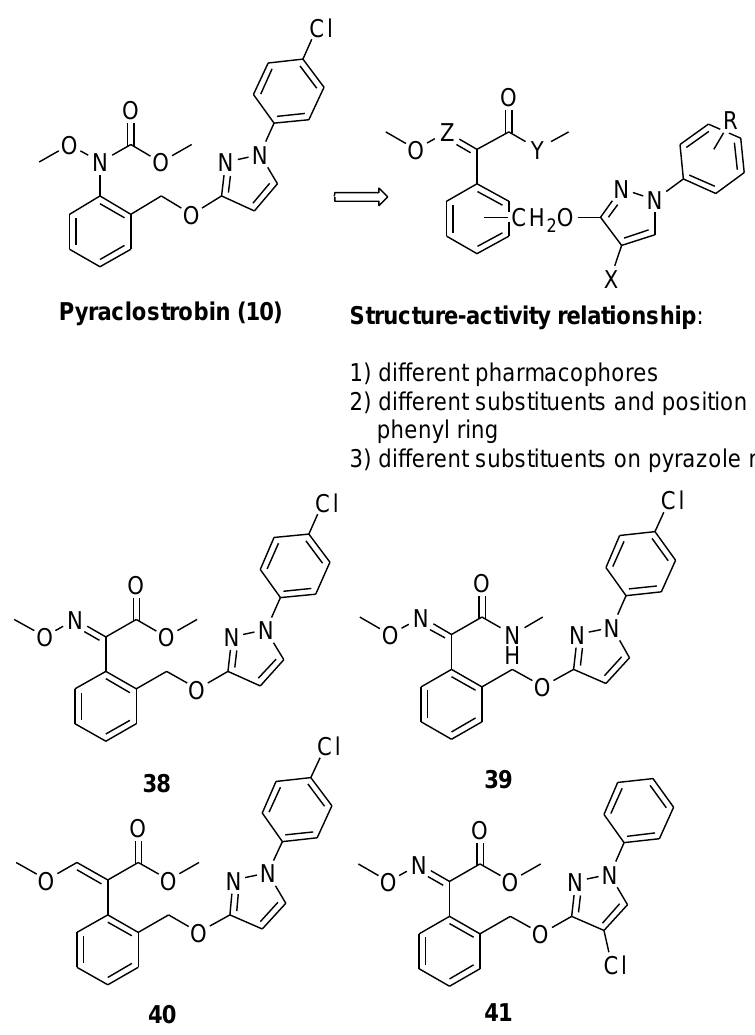
Figure 10. Structure of pyraclostrobin analogs from Reference [33].